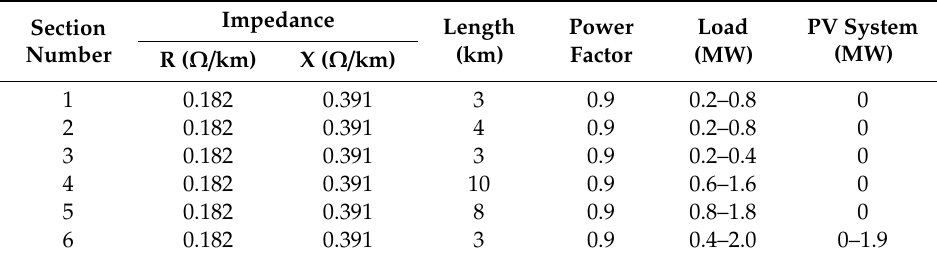
Table 2. Simulation Data.